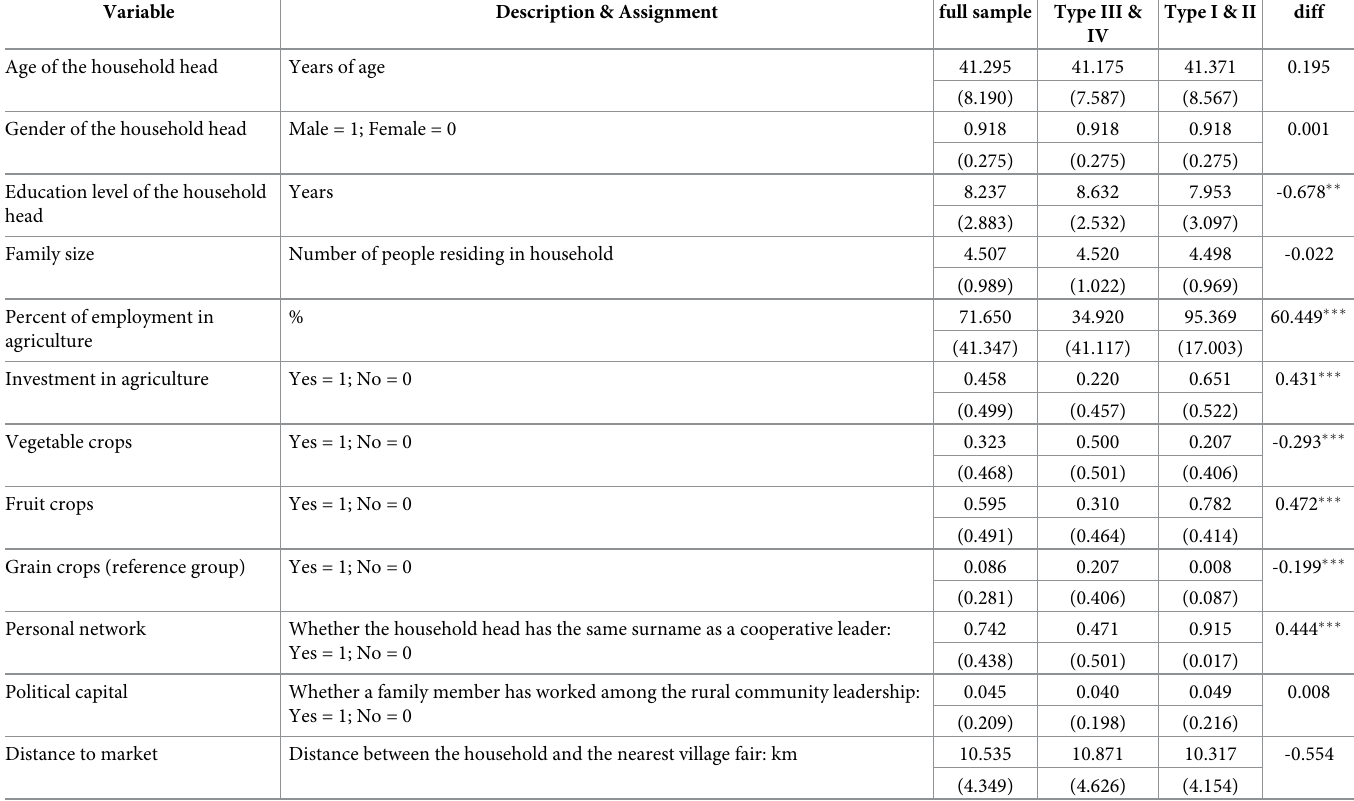
Table 4. Controlled